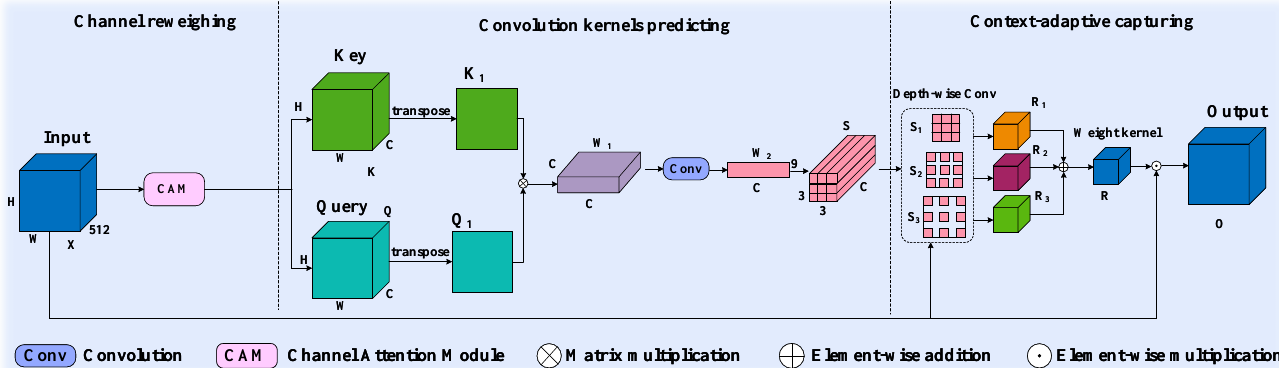
Figure 2. Overview of the proposed ACAM. To make better use of the contextual cues, we introduce ACAM to aggregate the contextual cues adaptively. Different from current context aggregating methods, the ACAM generates the weight vectors according to the global context cues of all feature channels. Moreover, the dilated depth-wise convolutions with different dilation factors are introduced to capture contextual cues. In this way, we integrate the contextual cues adaptively for better